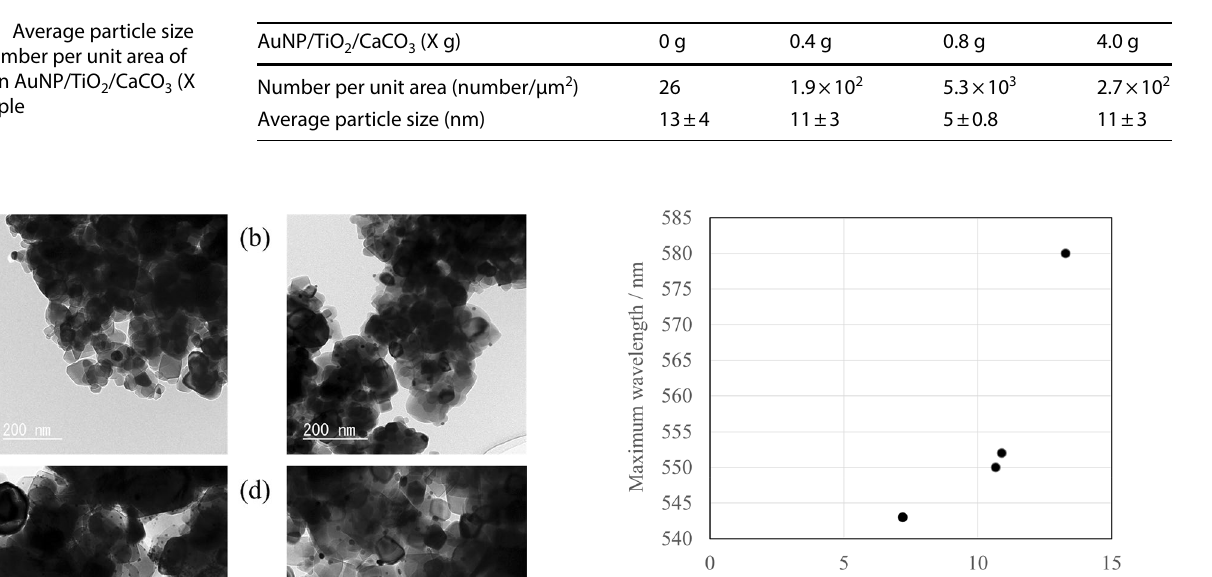
Fig. 10 Maximum absorption wavelength in the visible light range as a function of the Au nanoparticle size estimated from transmis- sion electron microscopy images